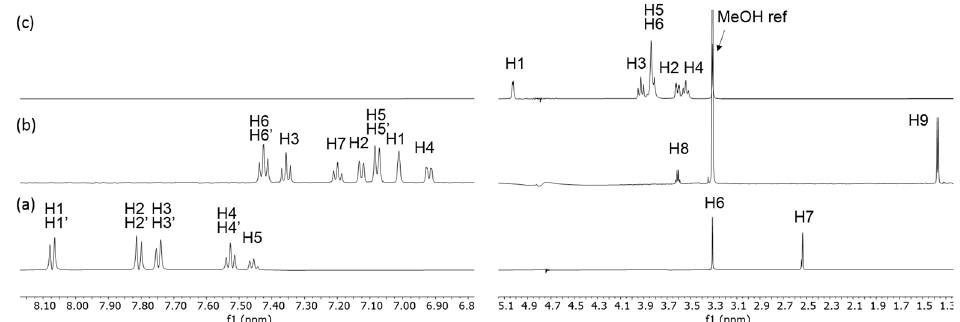
Figure 2. The 1 H NMR assignation of ( a ) fenbufen, ( b ) fenoprofen, and ( c ) BCyD. The change in the chemical shift of the guest signals as complexation occurs As shown in Equation (1), the observed chemical shift ( δ obs ) is the average of the (CIS—Complexation Induced Shift) can be used to determine the stability constant. chemical shift of the free guest ( δ G ) and the complexed ( δ C ) species weighted by their mole fraction ( χ ). In addition to the stability constants, the stoichiometry of the